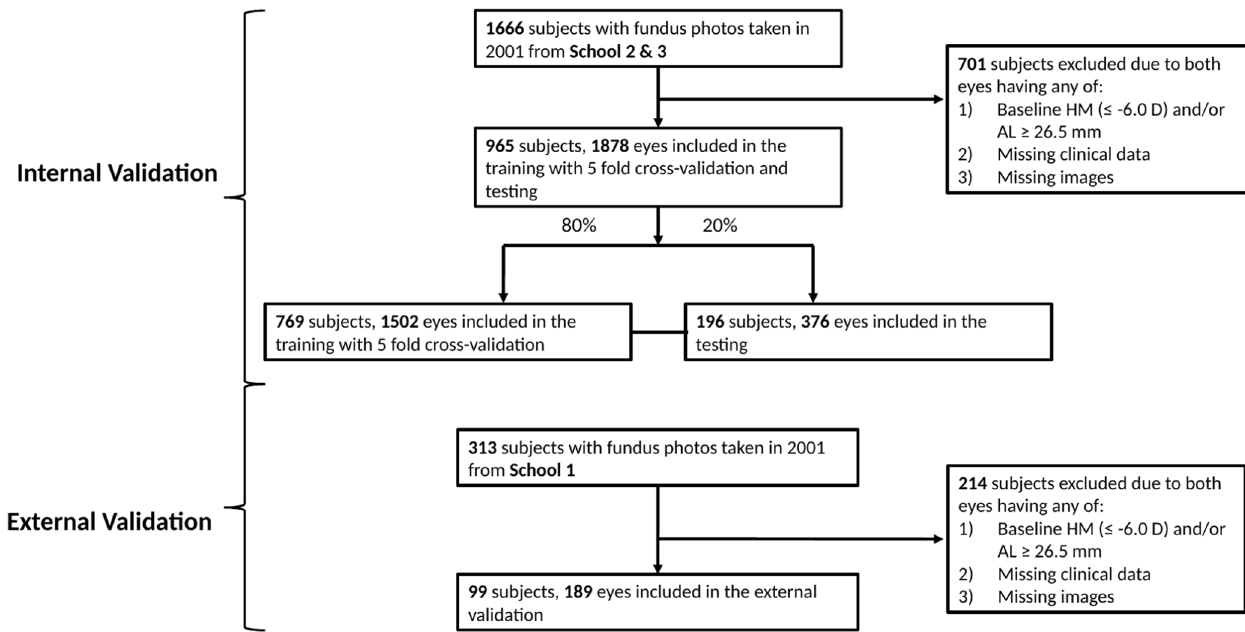
Fig. 5 Flowchart of dataset. Singapore Cohort of Risk factors for Myopia was used in Deep Learning System training/internal validation (School 2 and 3) and external validation (School